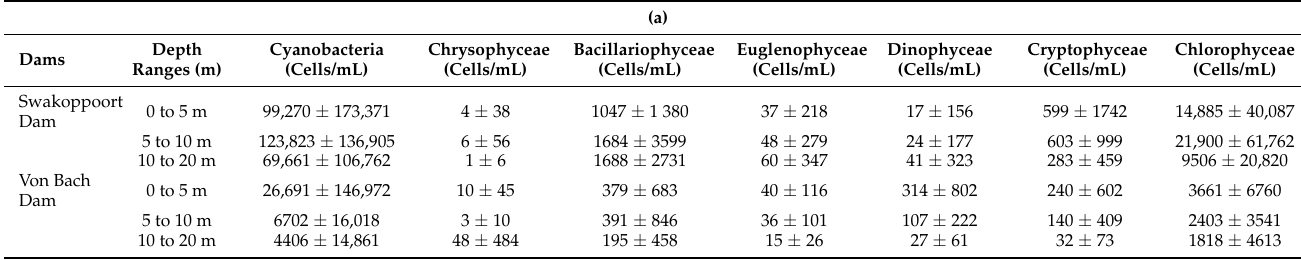
Table 4. The average ± standard deviation of the phytoplankton communities of the Swakoppoort and Von Bach Dams at (a) different depths and (b) among seasons.